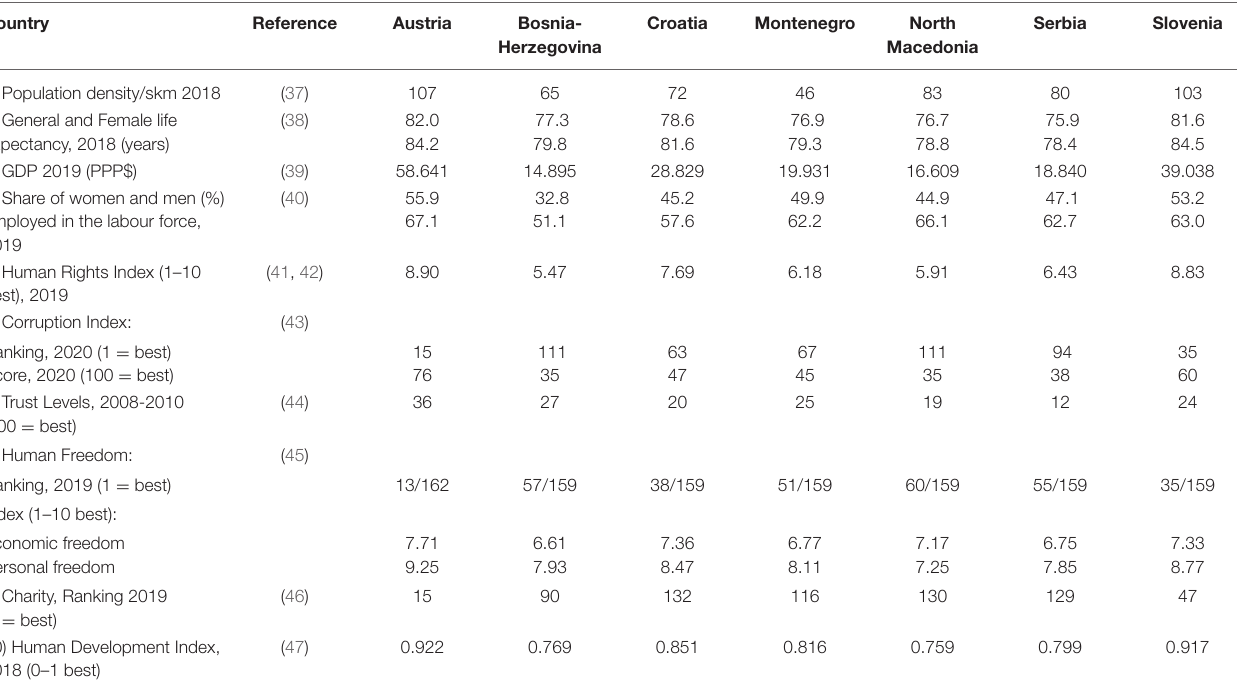
TABLE 7 | National parameters of potential relevance, available for the six successor states of the former Yugoslavia compared to Austria. Country Reference Austria Bosnia-